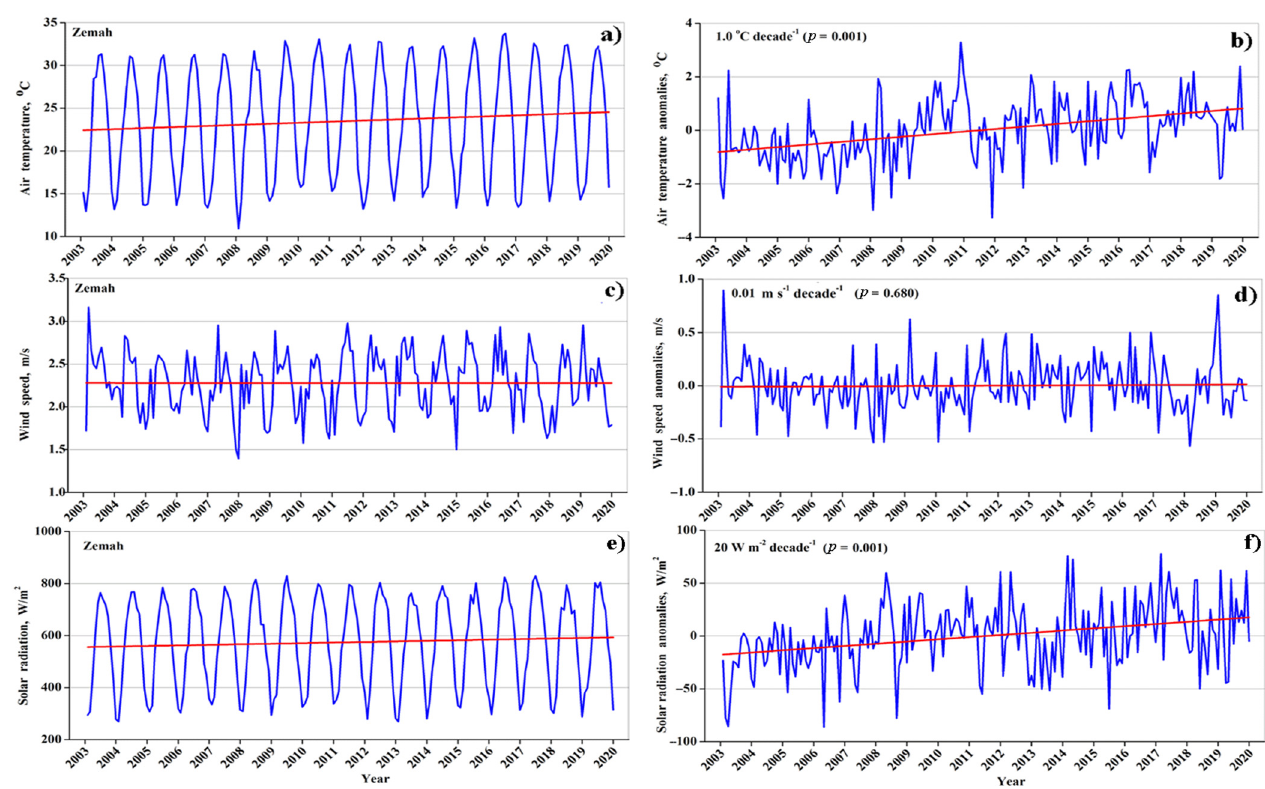
Figure 4. Month-to-month variations of ( top panel ) ( a , b ) 2-m air temperature, ( middle panel ) ( c , d ) near-surface wind speed, and ( bottom panel ) ( e , f ) surface solar radiation taken at the Zemah meteorological station, located in the vicinity of Lake Kinneret, during the 17-year period under study. The left column ( a , c , e ) represents original monthly data while the right column ( b , d , f ) represents their associated deseasonalized monthly anomalies. The straight red lines designate linear fits.